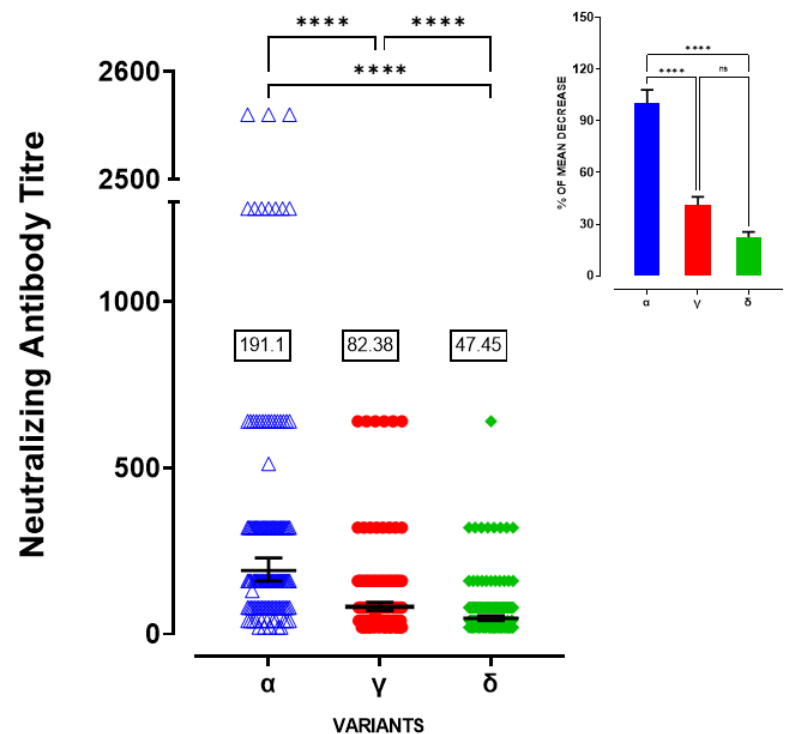
Figure 1. Neutralizing antibody titre against Alpha, Gamma and Delta variants **** p < 0.0001; Inset: Percentage (%) of mean decrease for neutralizing antibody titre against Gamma and Delta variants with respect to Alpha **** p < 0.0001; ns = not significant .